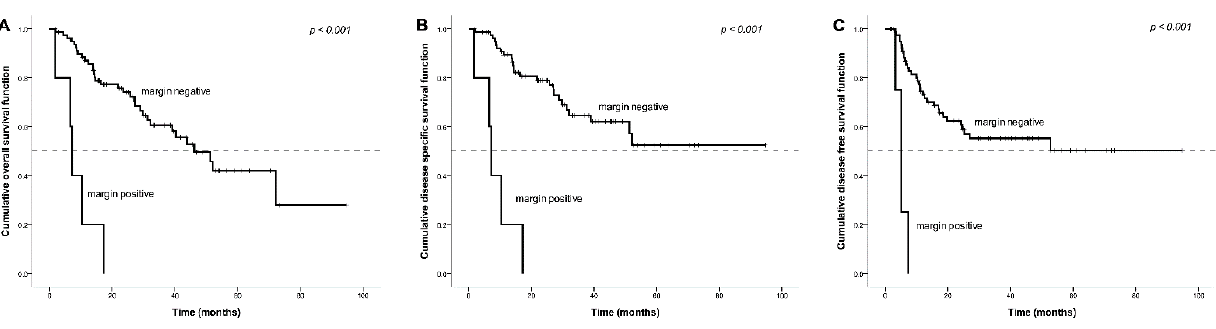
Figure 2. Kaplan–Meier survival curve by surgical margin groups. Impact of surgical margin after salvage total laryngectomy (TL) on ( A ) overall survival, ( B ) disease-specific survival, and ( C ) disease-free survival.